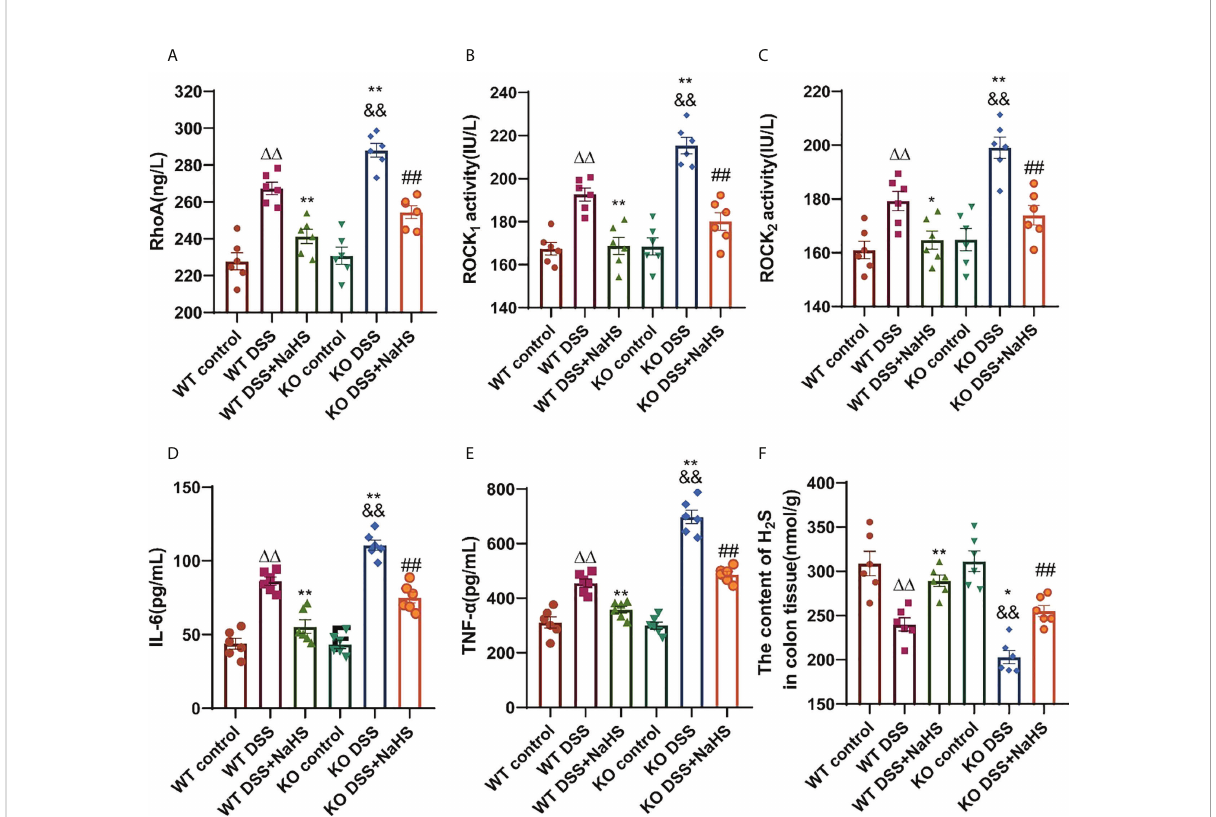
FIGURE 6 Effect of cystathionine- g -lyase (CSE)-derived hydrogen sul fi de (H 2 S) on colonic RhoA, Rho kinase 1 (ROCK 1 ), Rho kinase 2 (ROCK 2 ) protein activity and changes of interleukin-6 (IL-6) and tumor necrosis factor- a (TNF- a ) in mice sera, and hydrogen sul fi de (H 2 S) content in colon. Data are expressed as the mean±SEM, N=6. RhoA activity (A) , ROCK 1 activity (B) , ROCK 2 activity (C) , IL-6 (D) , and TNF- a (E) in sera determined by ELISA. The concent of H 2 S in colon (nmol/g protein) determined by ELISA (F) . DD P < 0.01 vs wild-type(WT) control group; *P < 0.05, **P < 0.01 vs WT dextran sodium sulfate (DSS) group; && P < 0.01 vs knockout (KO) control group; ## P<0.01 vs KO DSS